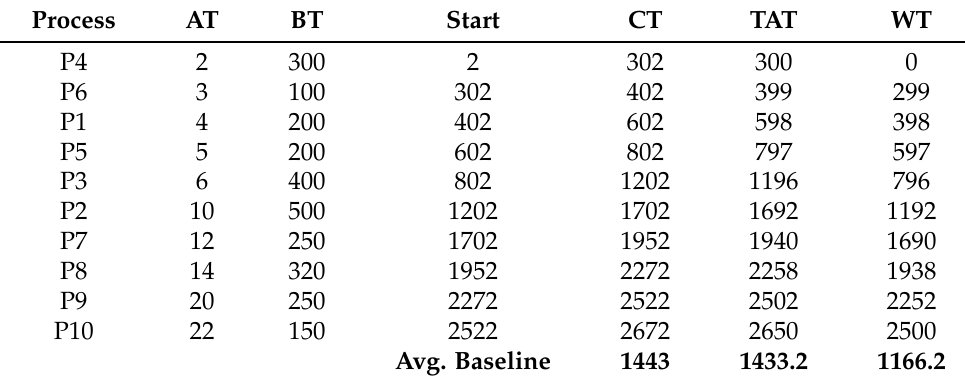
Table 6. Torque job execution order on a single node.